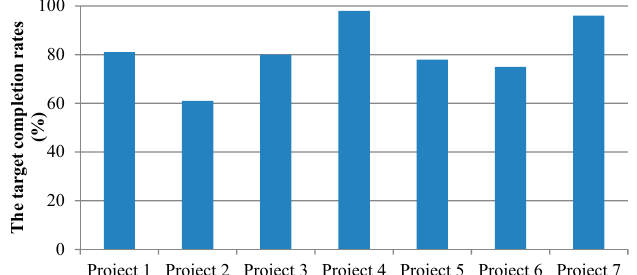
Figure 4. The target completion rates of the groundwater exploitation restriction projects. Project 1 represents highly efficient water saving projects in the well irrigation area; Project 2 represents surface water substitutes for groundwater engineering; Project 3 represents adjustment of planting modes; Project 4 represents conservation tillage; Project 5 represents spring irrigation for winter wheat (water saving and stable production); Project 6 represents water and fertilizer integration (vegetables); and Project 7 represents water and fertilizer integration (wheat and